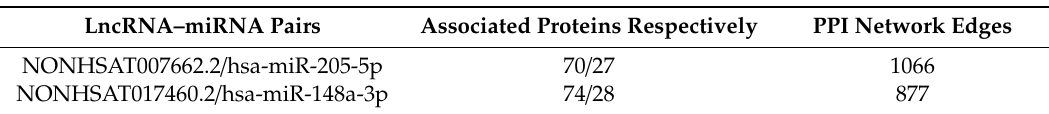
Table 7. Two specific lncRNA–miRNA pairs and their protein–protein interaction (PPI) network constructed by associated proteins.